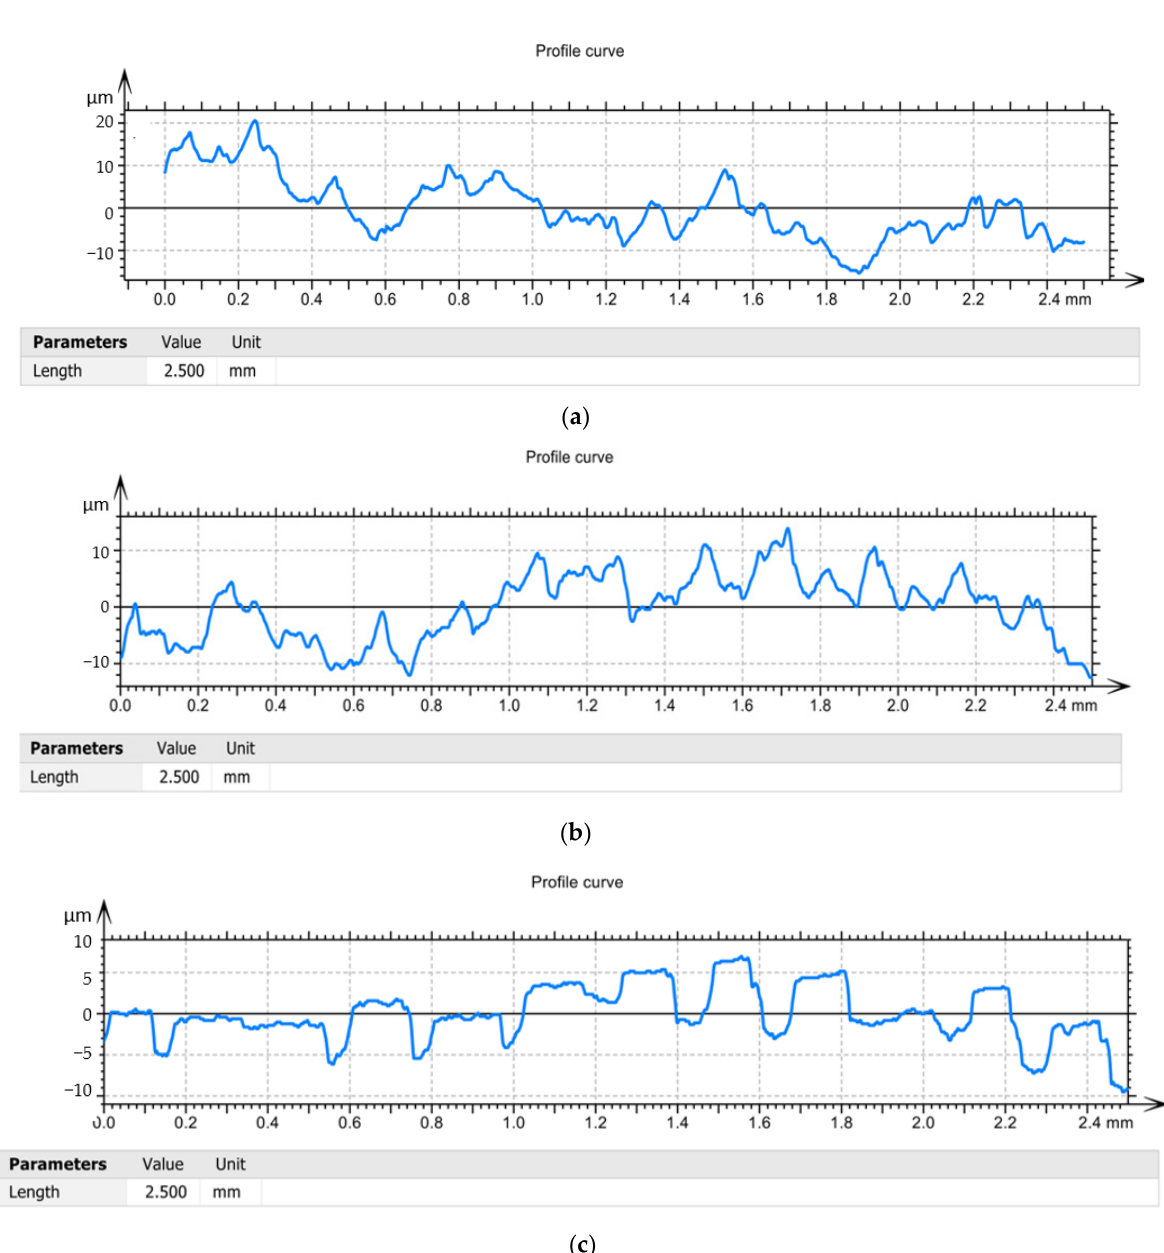
Figure 8. Profile curve: ( a )—in the case of machining with a V01 cutting tool; ( b )—in case of machining with V02 cutting tool; ( c )—in case of machining with cutting tool V03.